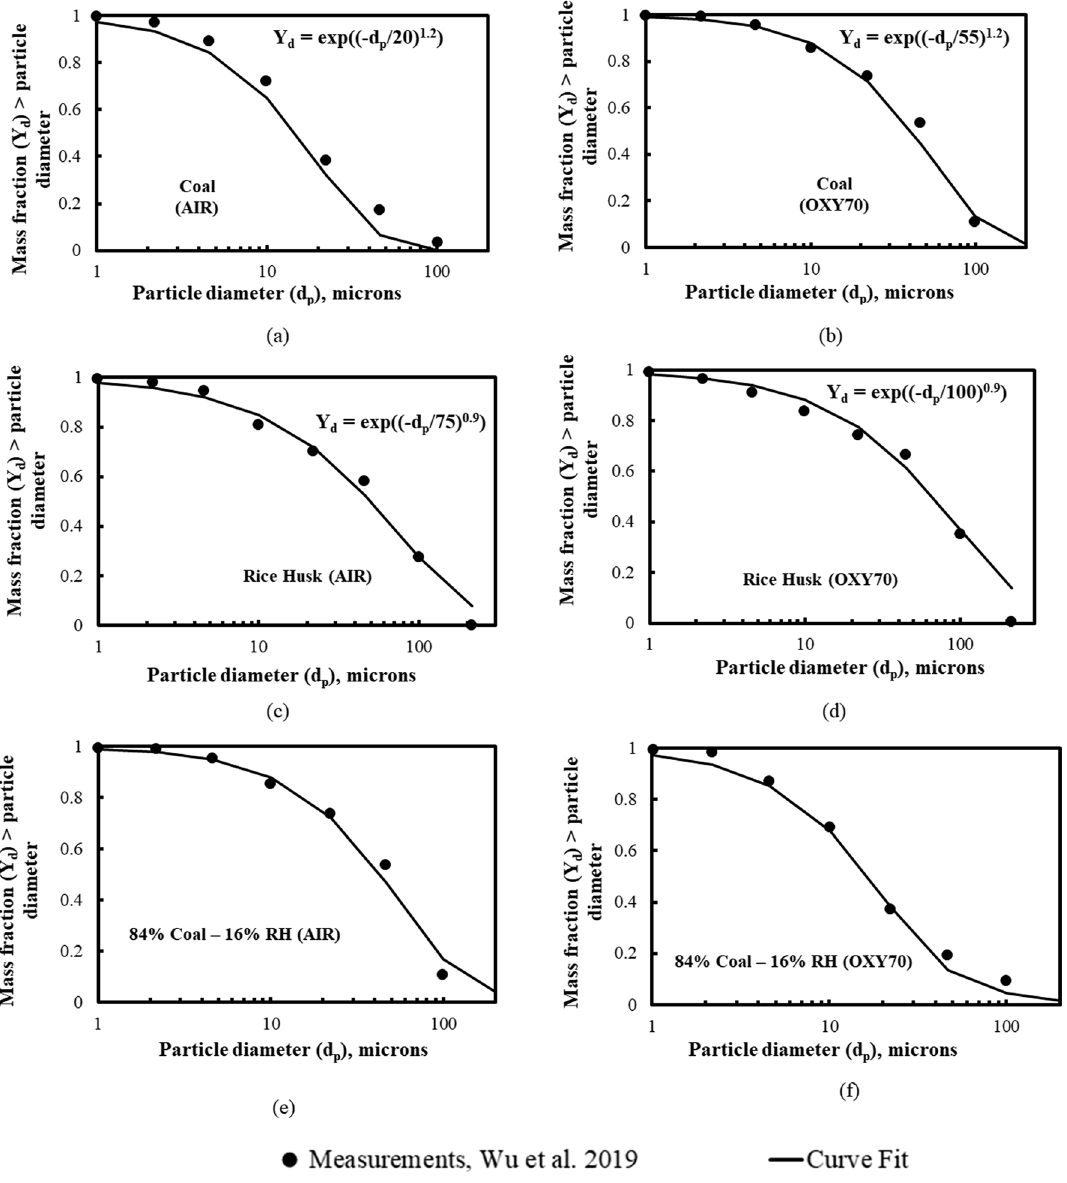
Fig. 3 The measured and modeled particle size distribution (PSD) of the fly-ash particles near the deposit probe (shown as a bold line). a